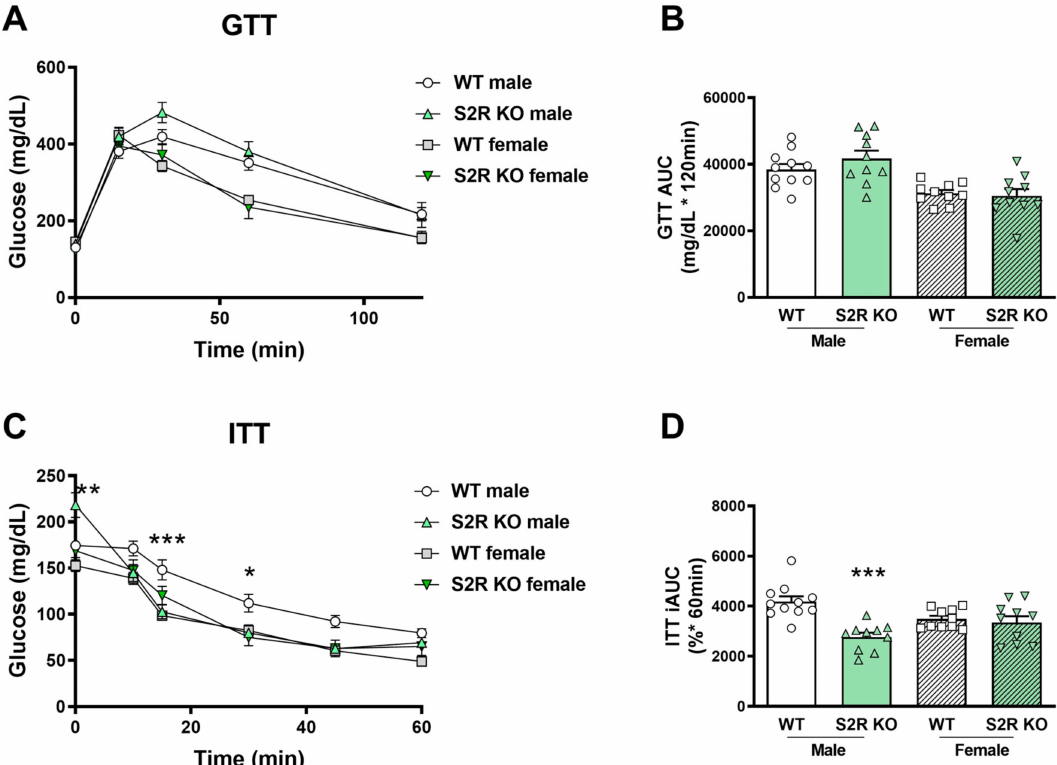
Figure 4. S2R ablation increases insulin tolerance in male, but not female, mice fed on HFD. GTT and ITT assays were performed after 6 weeks of HFD. ( A ). Time course of blood-glucose levels following i.p. injection of glucose (2.0 g/kg body weight). ( B ). Cumulative blood-glucose levels at 120 min after glucose injection. ( C ). Time course of blood-glucose levels following i.p. injection of insulin (1 U/kg body weight). ( D ). Cumulative blood-glucose levels at 120 min after insulin injection. Statistical analysis: Two-way ANOVA with Bonferroni’s multiple-comparisons test (* p < 0.05, ** p <